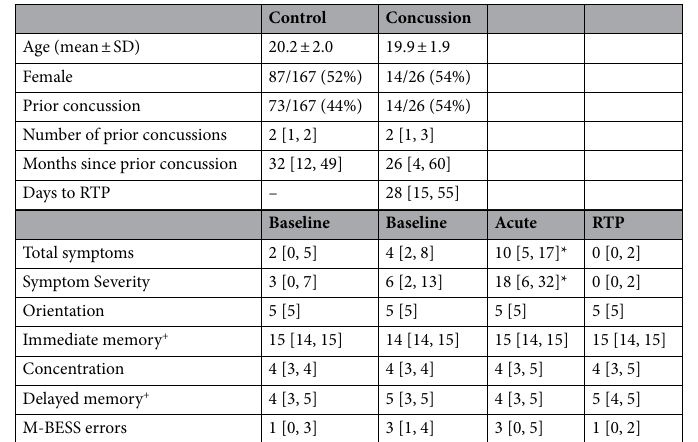
Table 1. Demographic and clinical data for athletes with concussion and controls. All non-binary variables except age are summarized by the median and interquartile range [Q1, Q3]. For tests of Immediate Memory and Delayed Memory, denoted by a ‘ + ’, statistics are based on a reduced sample of 68/167 controls, due to changes in scoring guidelines between SCAT3 and SCAT5. Significant differences in clinical scores at acute injury, relative to athletes’ own baseline, are noted with a